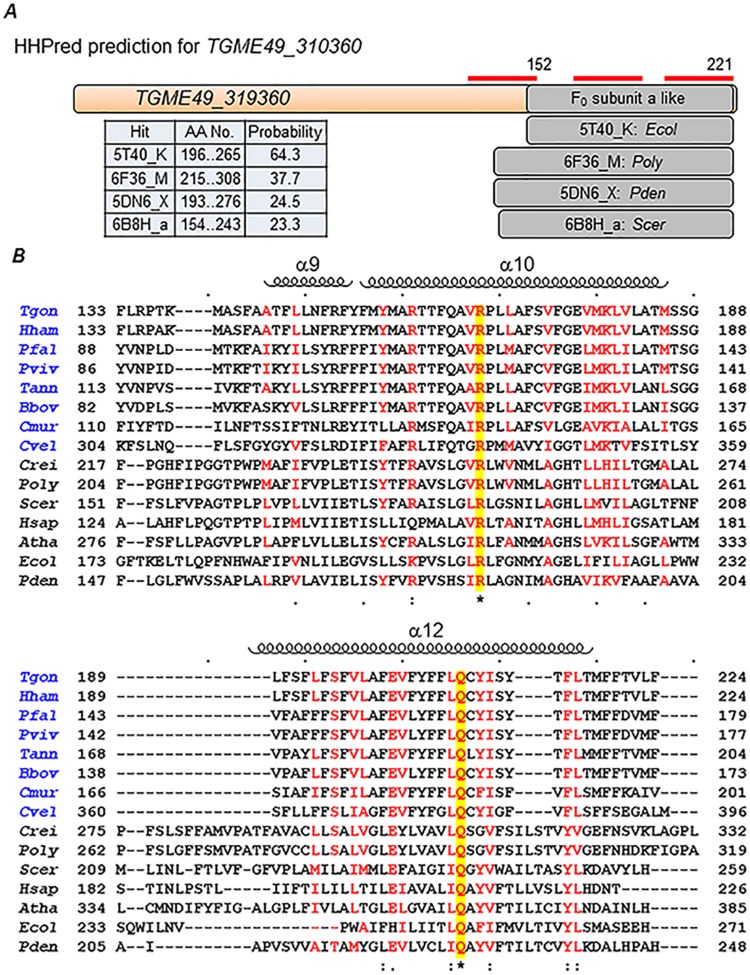
HHPred identification of novel FO subunit a based on conserved structural features.(A) Representation of the pairwise sequence alignments generated by HHPred [46,47] for the putative FO subunit a from T. gondii and 4 other FO subunit a proteins for which the structure is known. The table provides details of the amino acid length and a probability score for the prediction from the hit alignments. The red lines indicated the 3 transmembrane domains present in the T. gondii protein. (B) Protein sequence alignments and secondary structure information were made using the Clustal Omega [48] and ESPript [49] software, and only the C-terminal portion of respective proteins is shown. The names of alveolate species are highlighted in blue. For the nonalveolate species included in the alignment, the FO subunit a is either readily identified from sequence (Scer, Hsap, Atha, Ecol, and Pten) or has been experimentally determined (Crei and Poly). Positions with similar amino acids are highlighted in red in the alignment. The arginine and glutamine residues, highlighted in yellow, are conserved in all species and important for function. The helices (α9, α10, and α12) shown are from the structure of Poly F-type ATP synthase. Species names: Tgon, T. gondii; Hham, Hammondia hammondi; Pfal, P. falciparum; Pviv, P. vivax; Tann, Theileria annulata; Bbov, B. bovis; Cmur, C. muris; Cvel, C. velia; Crei, C. reinhardtii; Poly, Polytomella sp.; Scer, S. cerevisiae; Hsap, Homo sapiens; Atha, A. thaliana; Ecol, Escherichia coli; Pden, Paracoccus denitrificans.